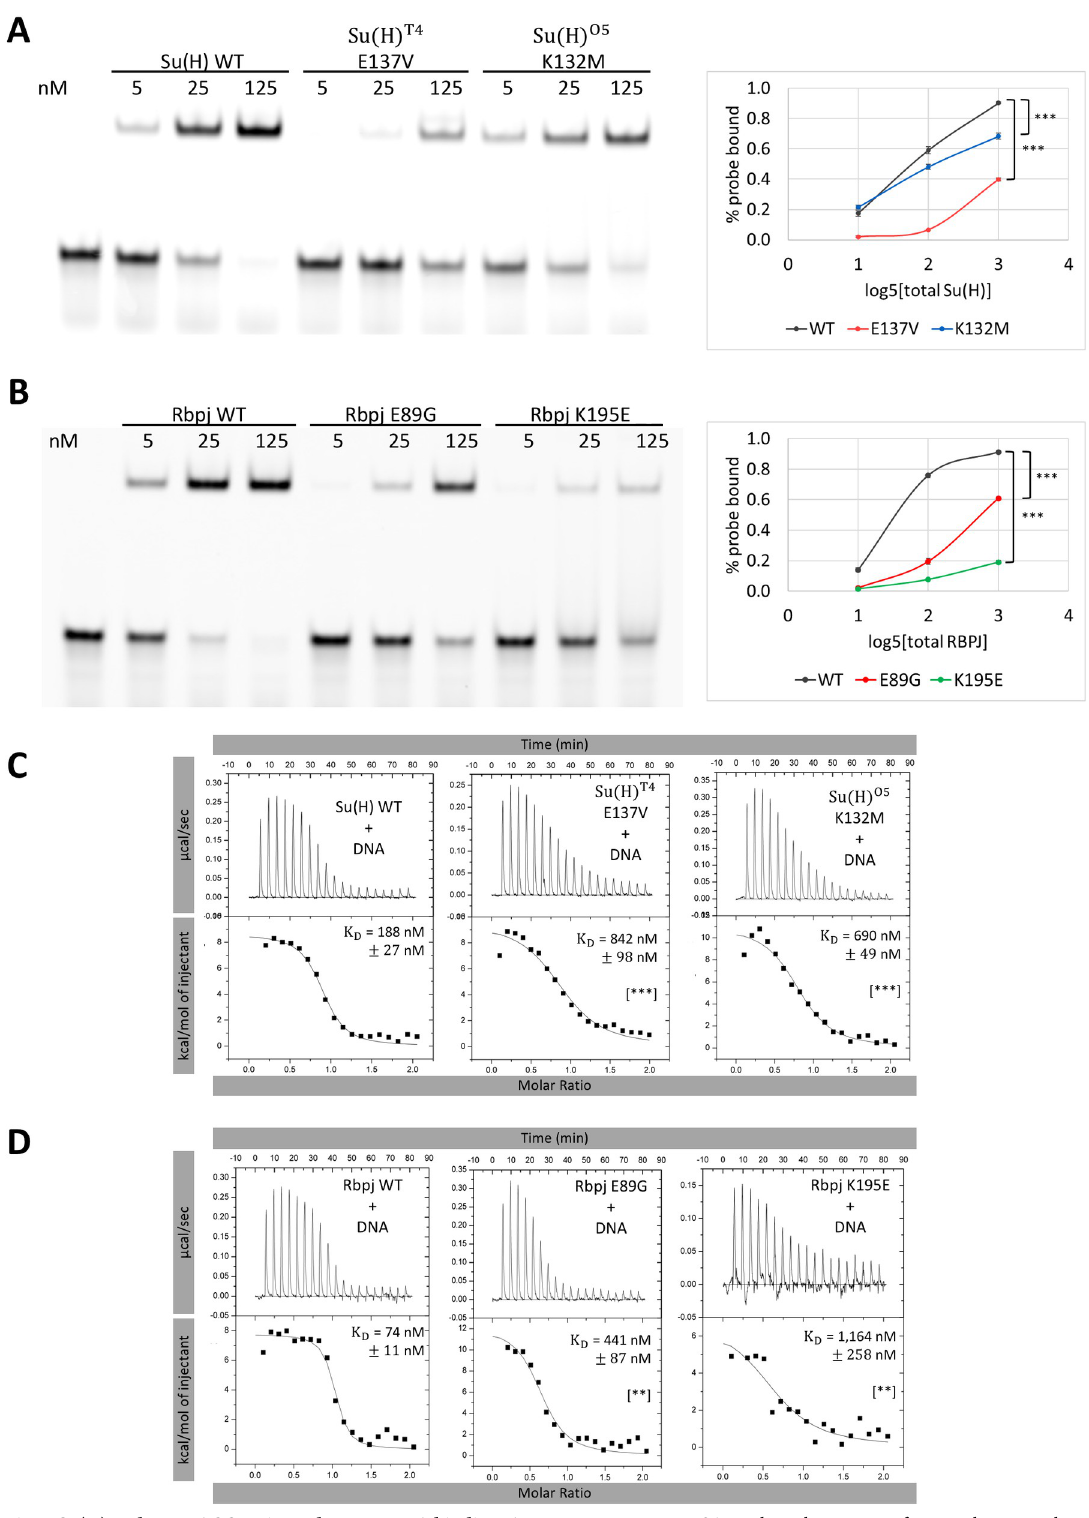
Fig 2. Su(H) and RBPJ AOS variants decrease DNA binding. A-B. Representative EMSAs with triplicate quantification shown on the right for purified (A) Drosophila Su(H) WT, E137V, and K132M proteins and (B) mouse Rbpj WT, E89G, and K195E proteins. P-values are reported for the 125 nM protein conditions and were determined by an ANOVA with Tukey Honest Significant Difference test ([ ���